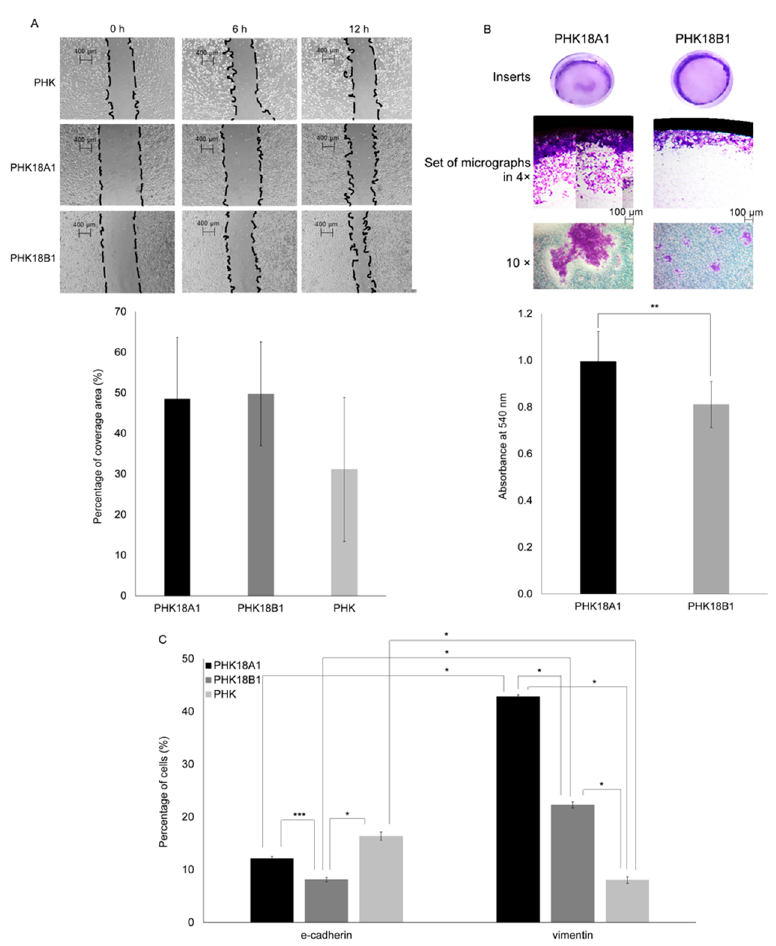
Figure 5. Migration and invasion potential, and EMT phenotype of immortalized PHK18A1 and PHK18B1: ( A ) wound healing assays. Cells were seeded and a wound was made throughout the center of the well. Images illustrate representative wells from three independent experiments carried out in triplicate. Histograms show the average area covered 12 h after wounding; ( B ) invasion assay. Cells were plated in collagen-covered inserts in nonsupplemented KSFM and invasion was stimulated by adding KSFM 15% FBS outside the inserts. Cellular invasion was monitored for 72 h. Images are representative of three independent experiments conducted in triplicate. Histograms show the average absorbance at 540 nm. ** p = 0.02; ( C ) levels of proteins associated with epithelial– mesenchymal transition (EMT). Cells were seeded in low-attachment plates in triplicates. After 14 days, spheroids formed were disassembled and the levels of E-cadherin and vimentin assessed using flow cytometry. Percentage of E-cadherin and vimentin-positive cells are presented. The average of three experiments is shown. The T -test was used for statistical analysis. * p = 0.00, *** p = 0.03.